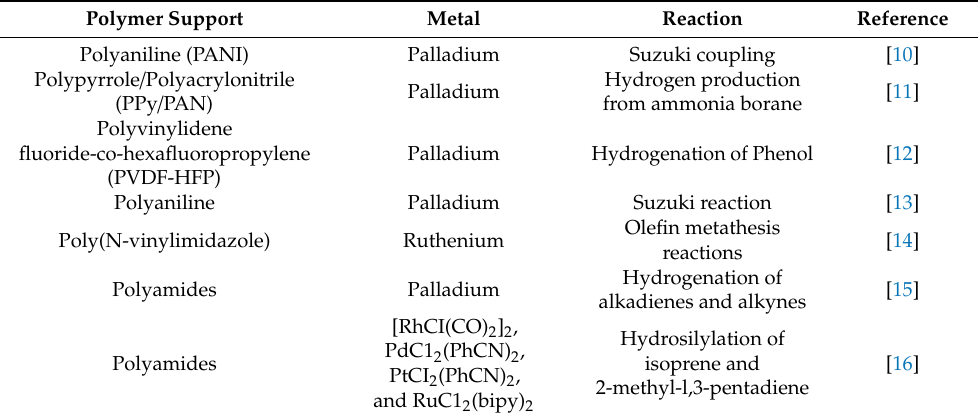
Table 1. Examples of catalysts fabricated from metals supported on